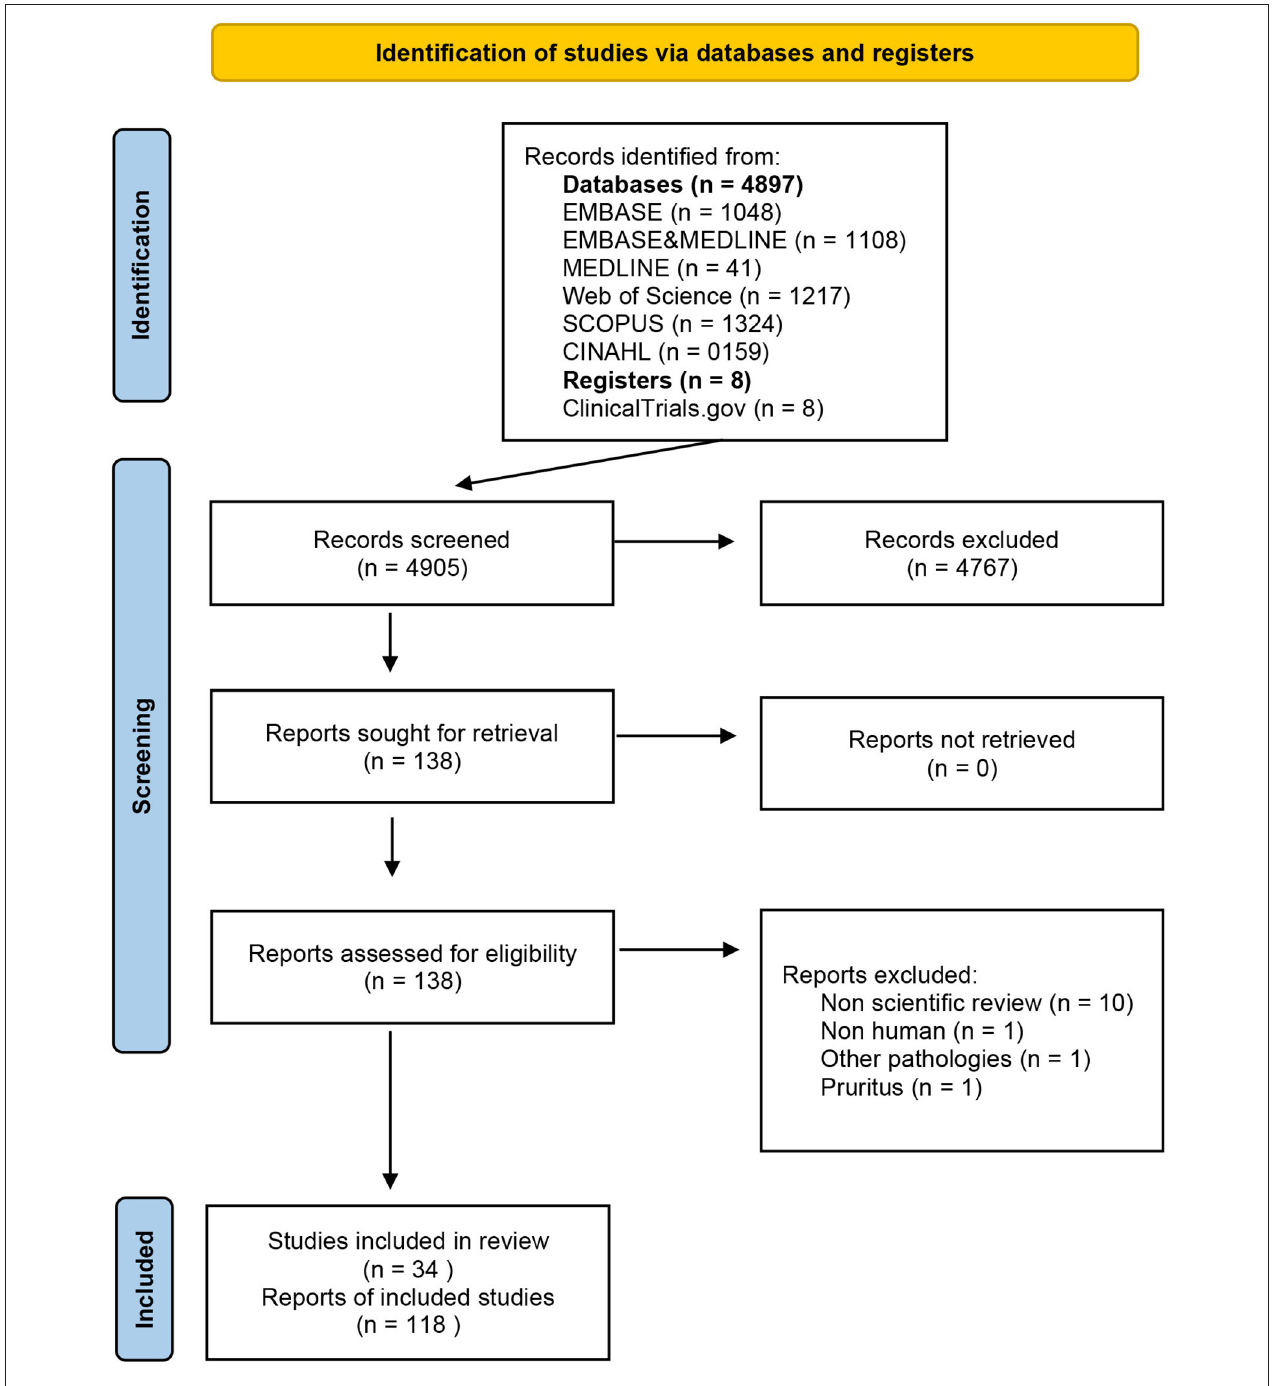
FIGURE 1 | PRISMA